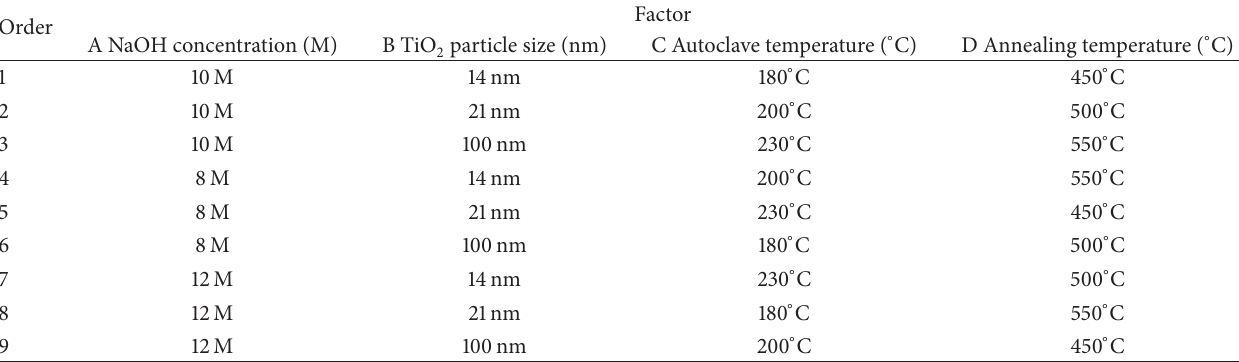
Table 2: Taguchi L9 orthogonal array.